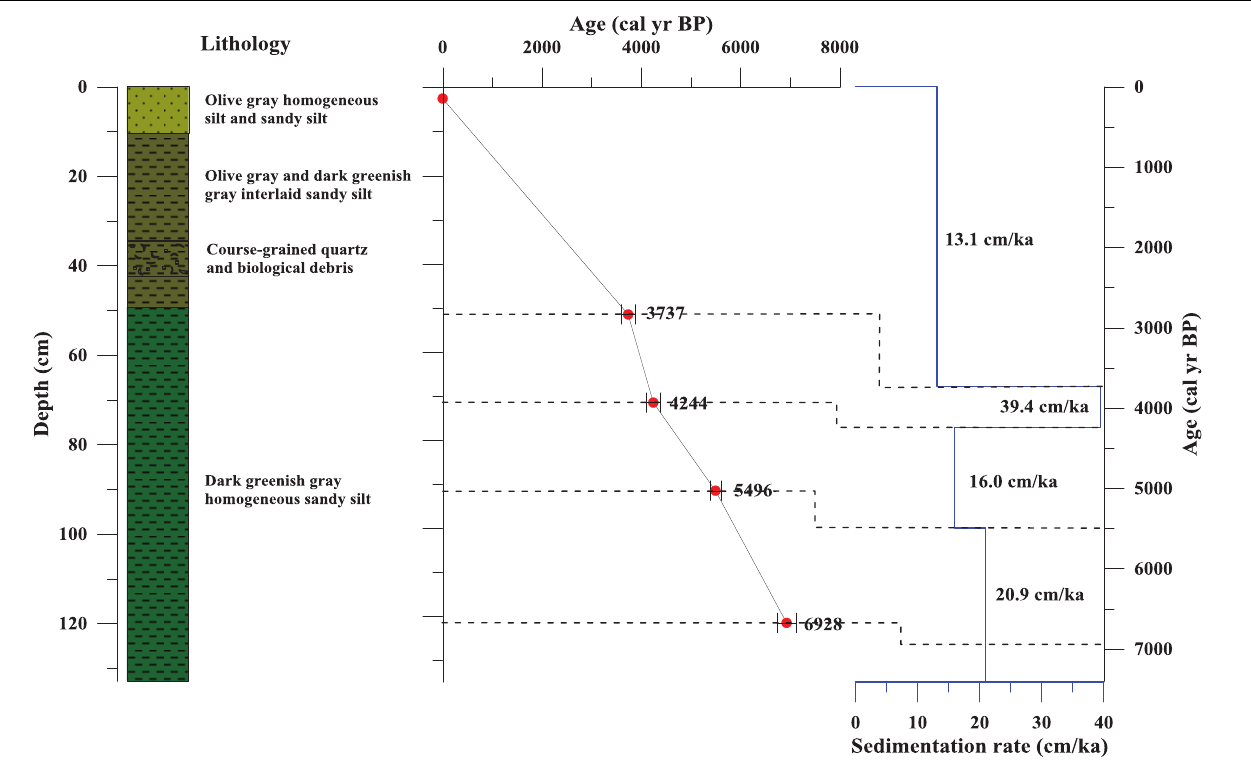
FIGURE 2 | Lithology and age model of Core K17 showing lithological description, foraminiferal AMS 14 C dating, and sedimentation rate.